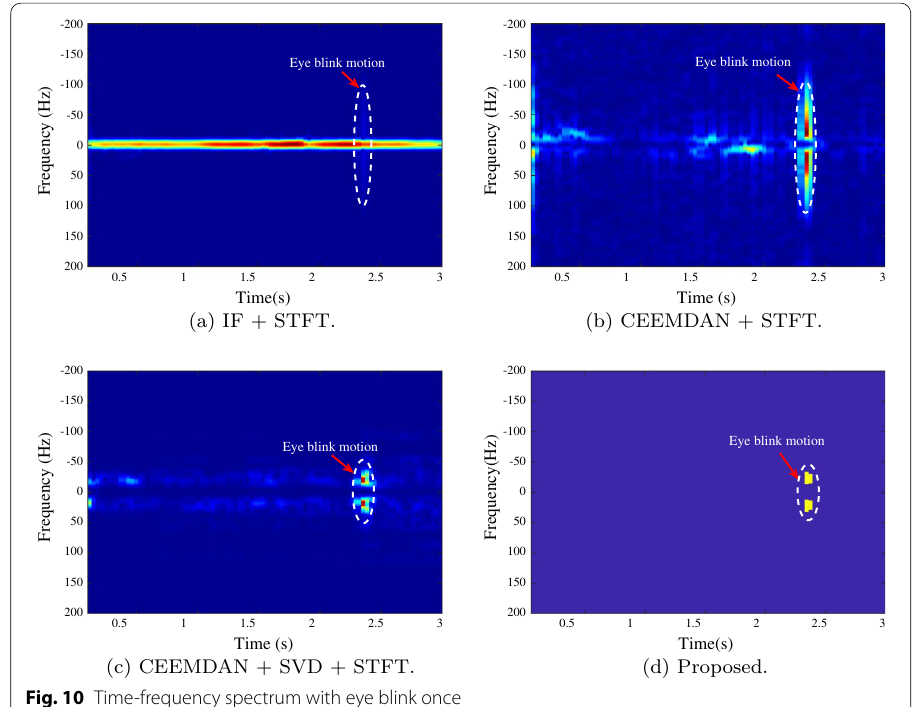
Fig. 10 Time-frequency spectrum with eye blink